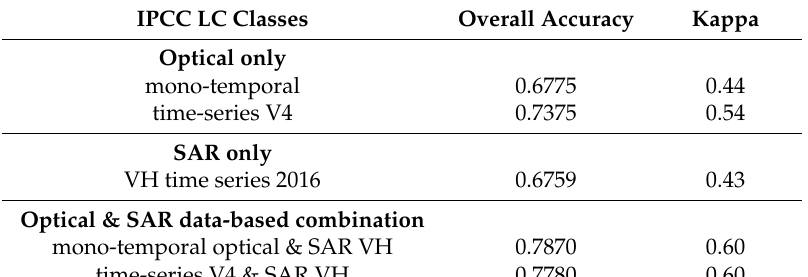
Table 7. Accuracies of optical only and optical/SAR combined approach for IPCC LC